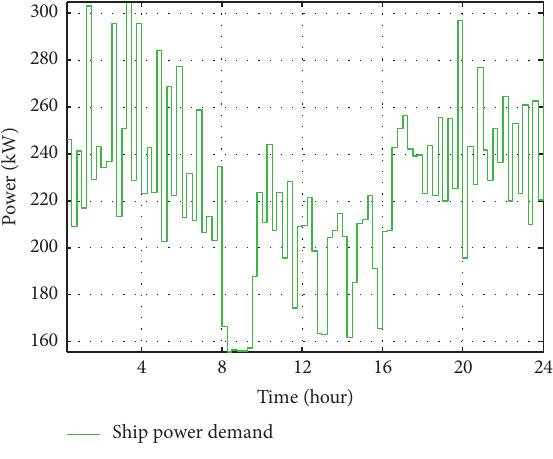
Figure 3: Recorded load power. Table 1: Parameters of DGs.